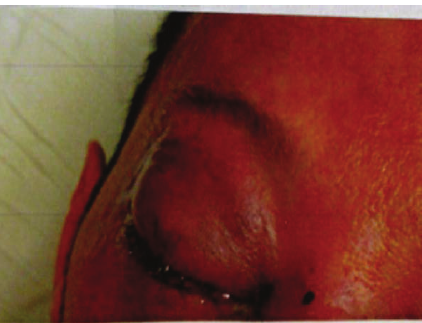
Figure 3: Head MRI T2w image showing hyperintensity in the right anterior temporal